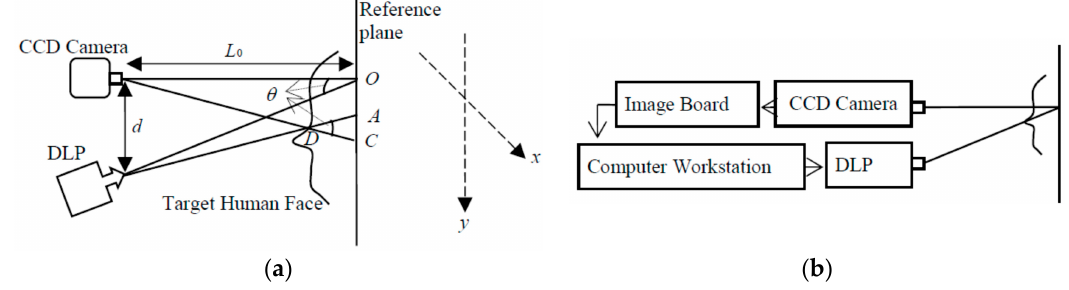
Figure 4. ( a ) Optical geometry of the system and ( b ) a diagram of the experimental setup.